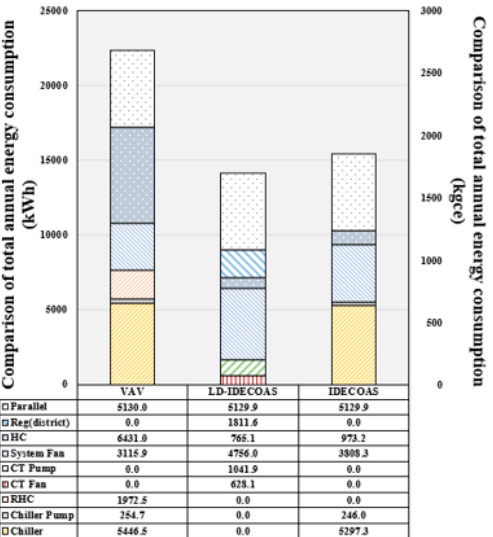
Figure 19. The total annual energy consumption of each system in the Beijing region.